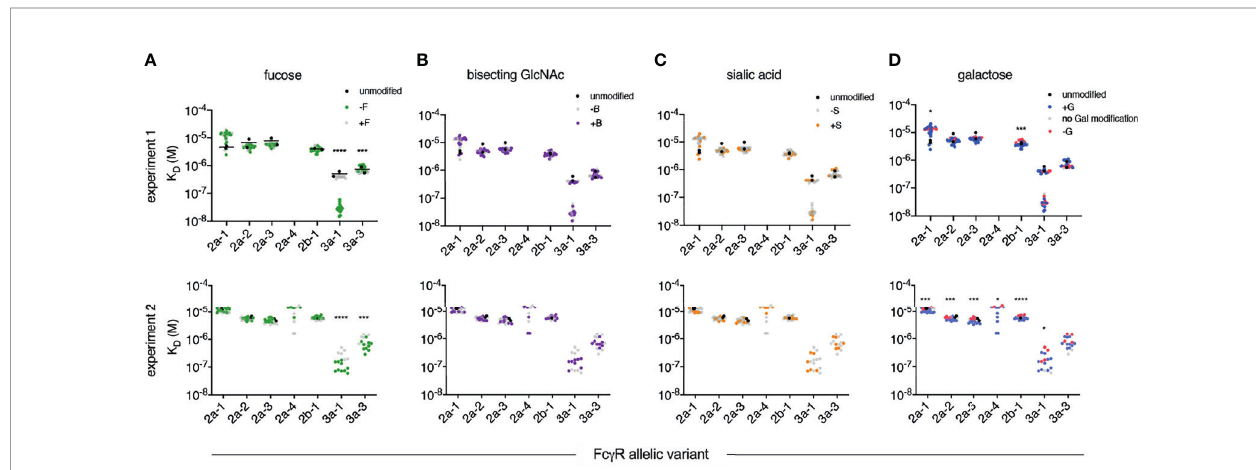
FIGURE 2 | Af fi nity of rhesus macaque Fc g Rs for a panel of human IgG1 glycovariants. Equilibrium dissociation constants (K D ) of rhesus macaque alleles having unique extracellular domains observed in two independent experiments (rows). Within each experiment, glycovariants were printed in replicate and each replicate is plotted. Results are presented such that each panel emphasizes a different category of glycomodi fi cation, including variable fucosylation (F) (A) , bisecting N-Acetylglucosamine (B) (B) , sialylation (S) (C) , and galactosylation (G) (D) . A natively glycosylated preparation (black) is plotted along with variants with (+) or lacking (-) the glycan emphasized in that panel. Statistically signi fi cant differences were tested using an unpaired t test comparing glycovariants with (+) and without (-) the modi fi cation (*p < 0.05, ***p < 0.0005, ****p <